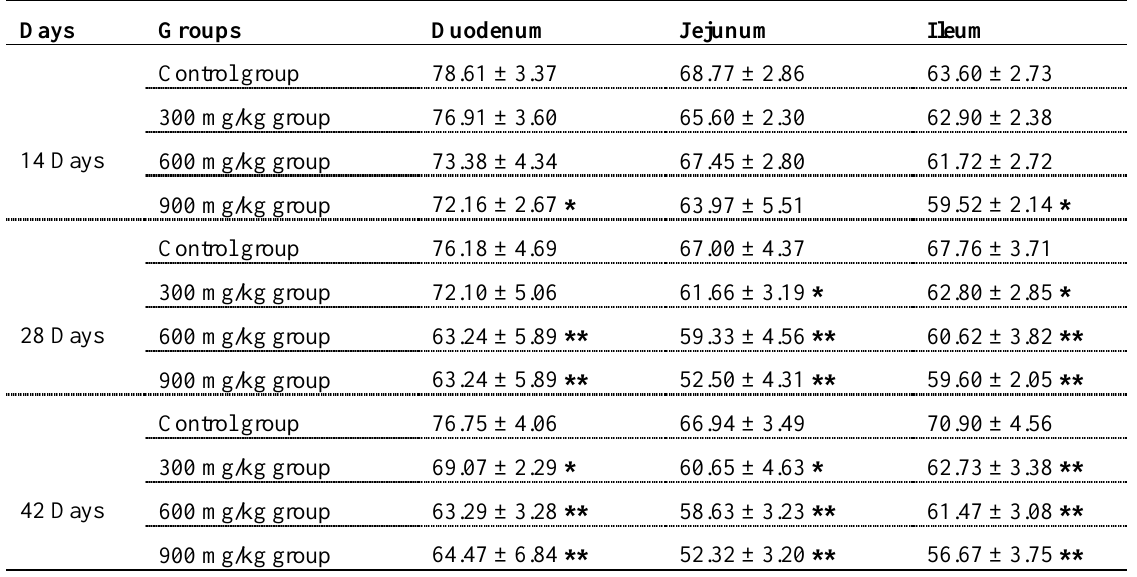
Table 1. Change of the T-SOD activity (U/mgprot) in the intestinal mucosa.